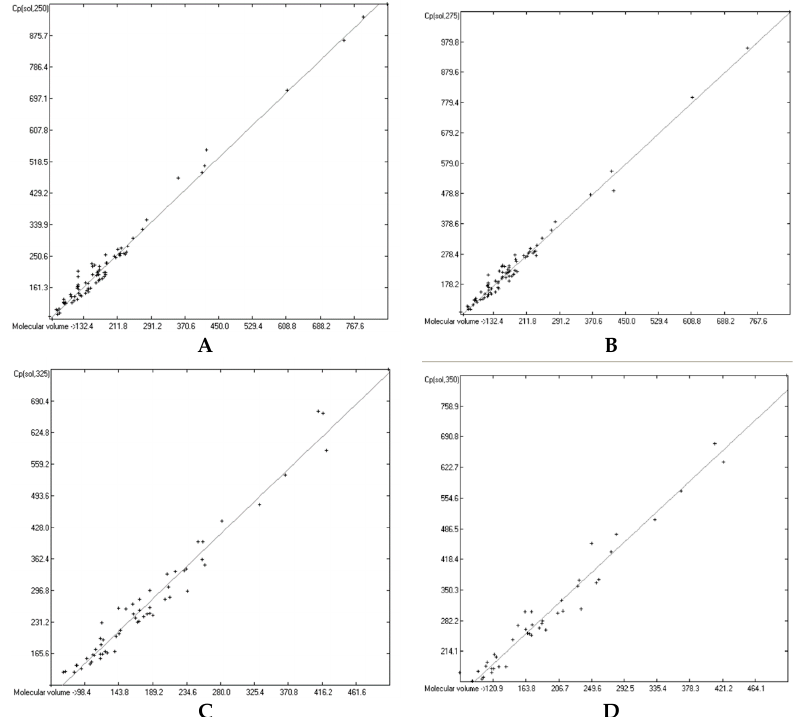
at various temperatures. A : 250 K. B : 275 K. C : 325 K. D : 350 K. various temperatures. ( A ): 250 K. ( B ): 275 K. ( C ): 325 K. ( D ): 350 K.